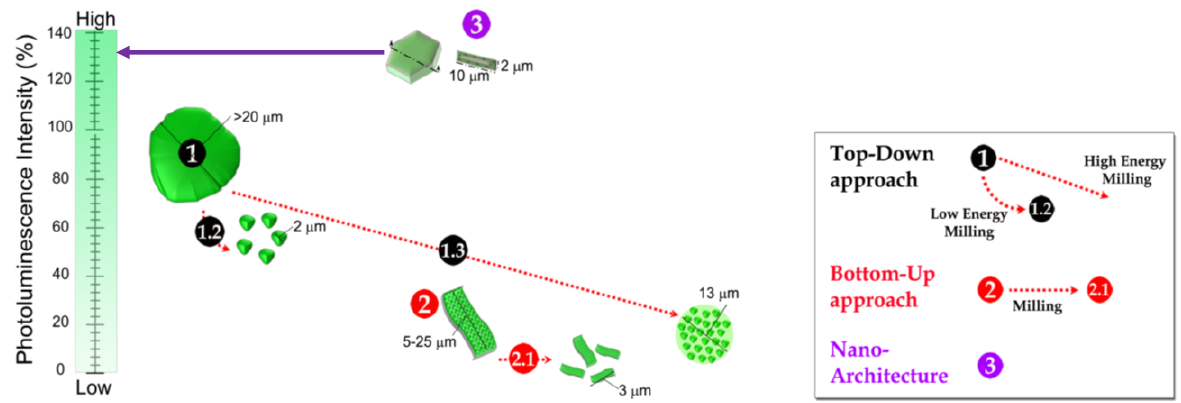
Figure 5. Scheme of the % of photoluminescence intensity, taking as reference commercial powder as a function of the morphology and particle size for SrAl 2 O 4 :Eu, Dy particles synthesized by top-down, bottom-up, and nano-architecture approaches.